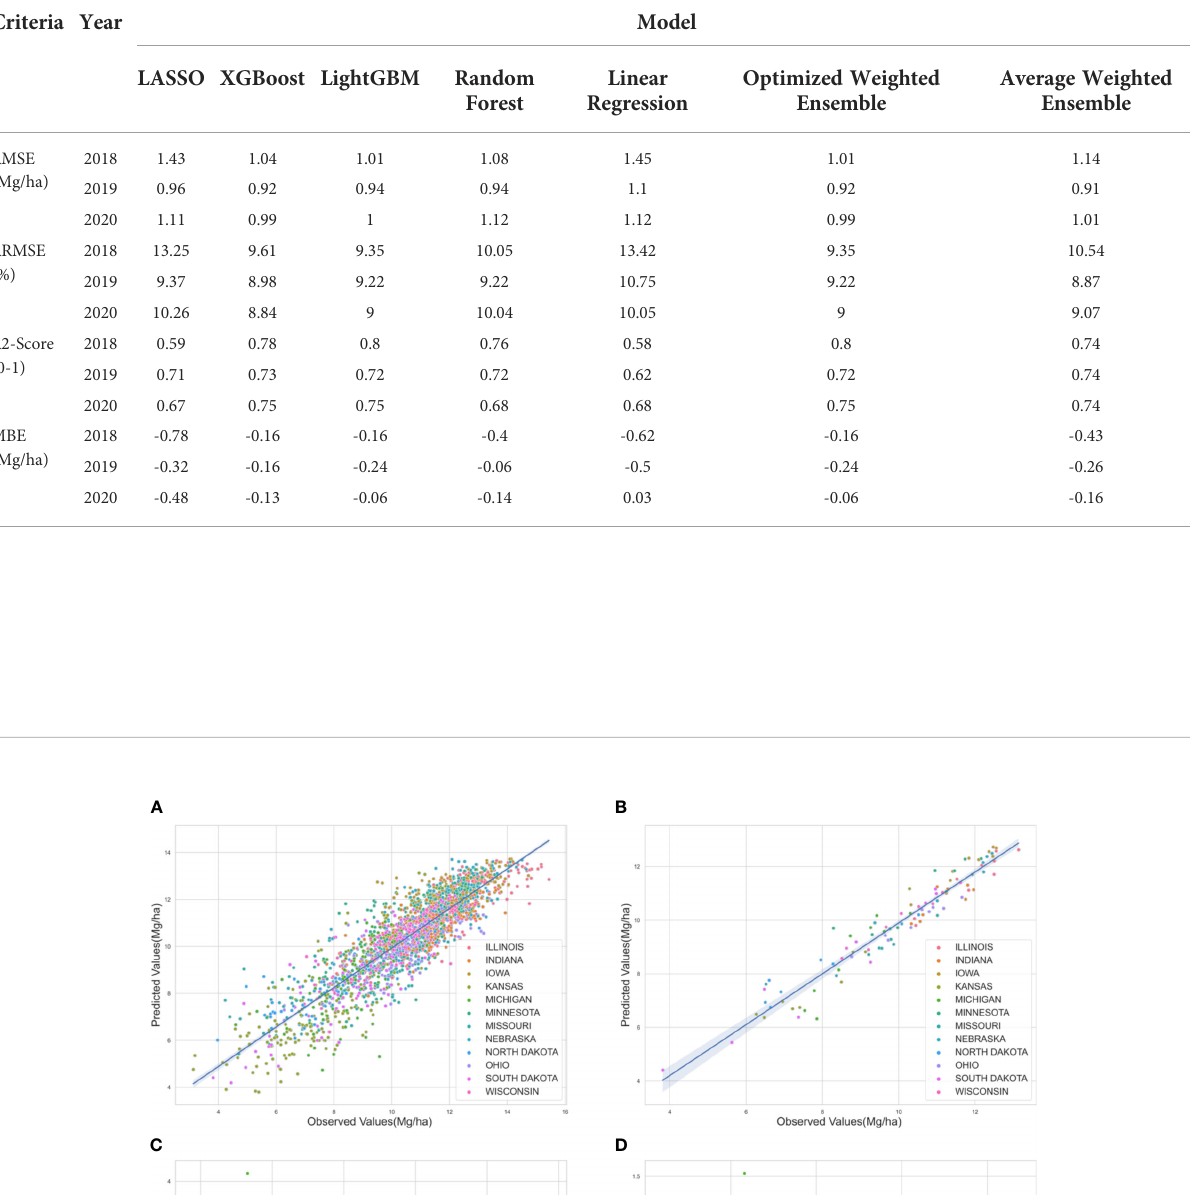
TABLE 2 Model evaluation statistical values.